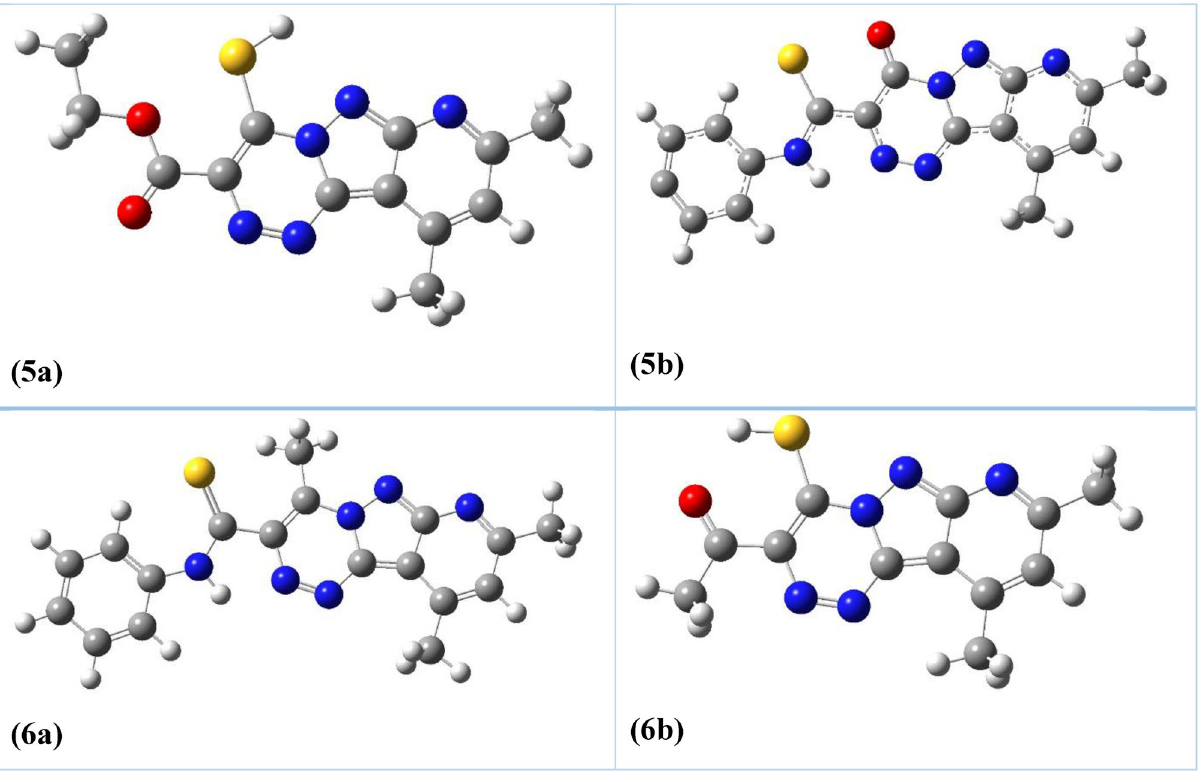
Figure 4. Optimized structures of compounds 5a , 5b , 6a , and 6b .